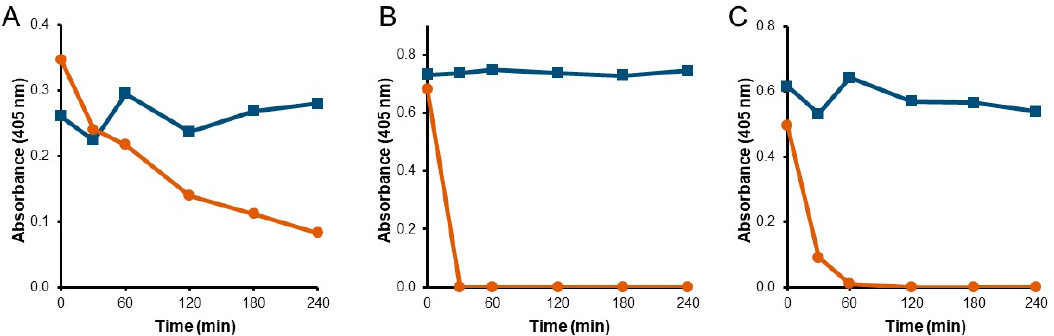
Figure 2. Functional stability of carbapenemases incubated with human intestinal chyme. P2A (A), NDM (B), or KPC (C), were incubated with buffer (blue squares) or mixed human chyme (orange circles). Samples were collected over 4 h and assessed for beta ‐ lactamase activity.